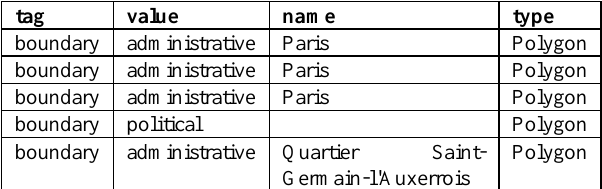
Table 5 . List of objects in which new ATM is